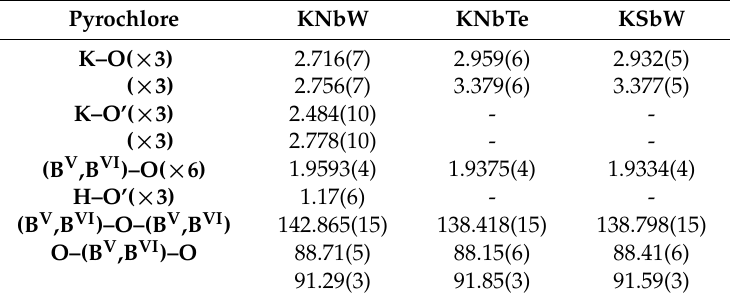
Table 2. Main interatomic distances (Å ) and angles (°) at 298 K.